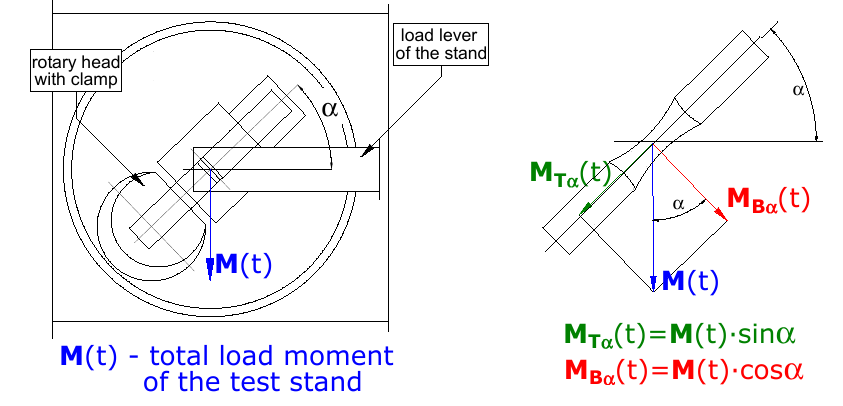
Figure 2. Load scheme of the specimen.